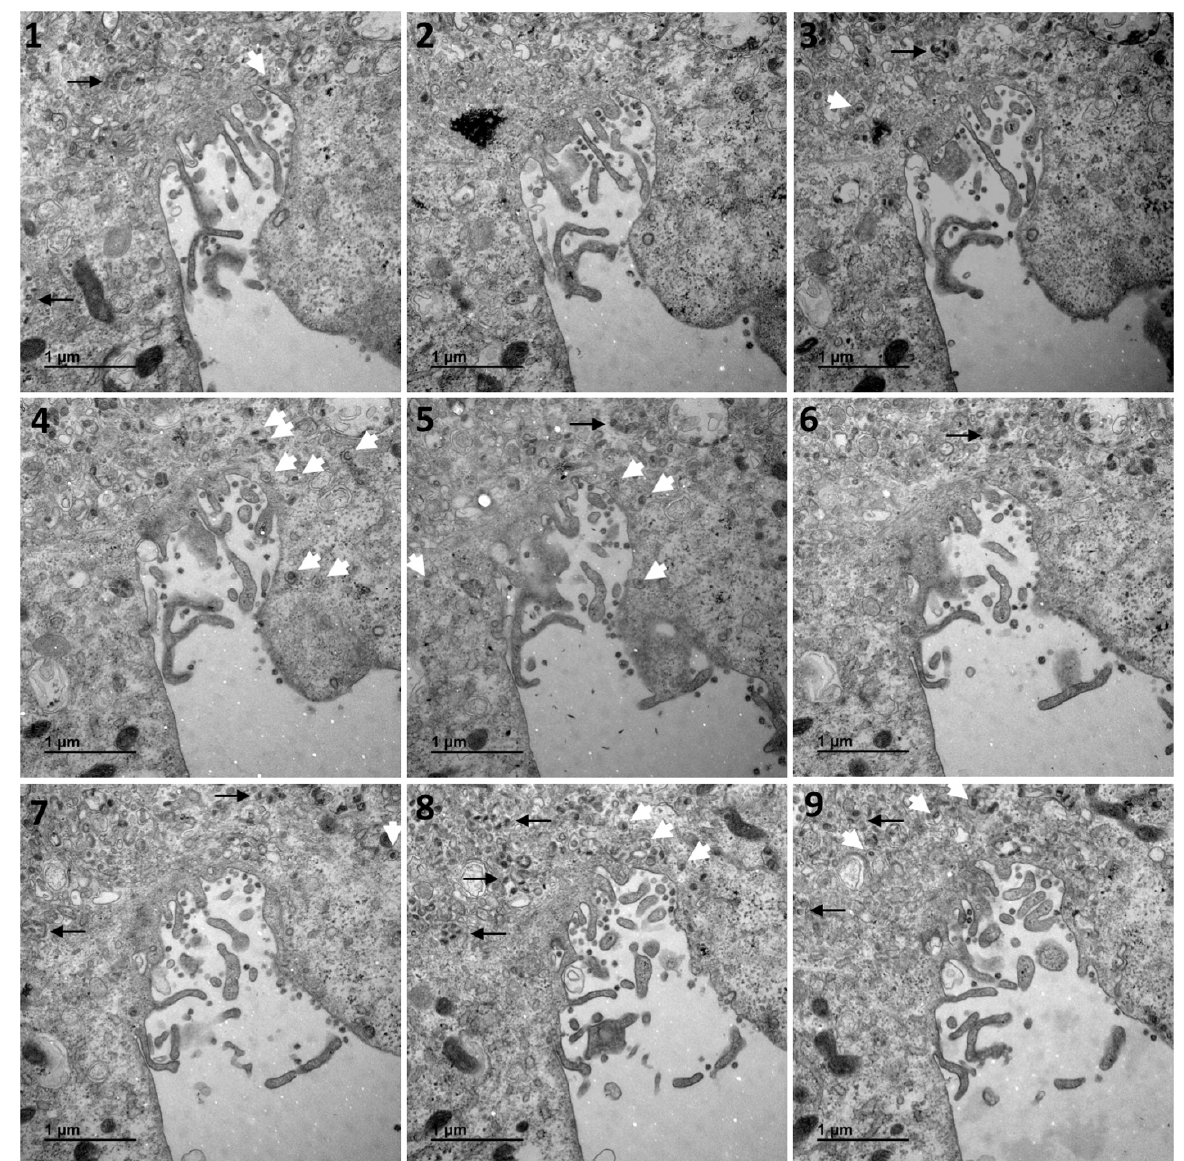
Figure 2. Serial TEM sections of cell A part 1, a region characterised by a large cytoplasm invagination rich in plasma membrane microvilli. Large intracellular vesicles rich in viral particles (thin black arrows) and small vesicles each con- taining a single viral particle (large white arrows) are shown on each serial section. These electron micrographs of a series of 9 TEM sections ( 1 – 9 ) are part of a larger series (11 sections) provided at high resolution in the Supplementary Materials. The numbers on the panels indicate the successive serial TEM sections.